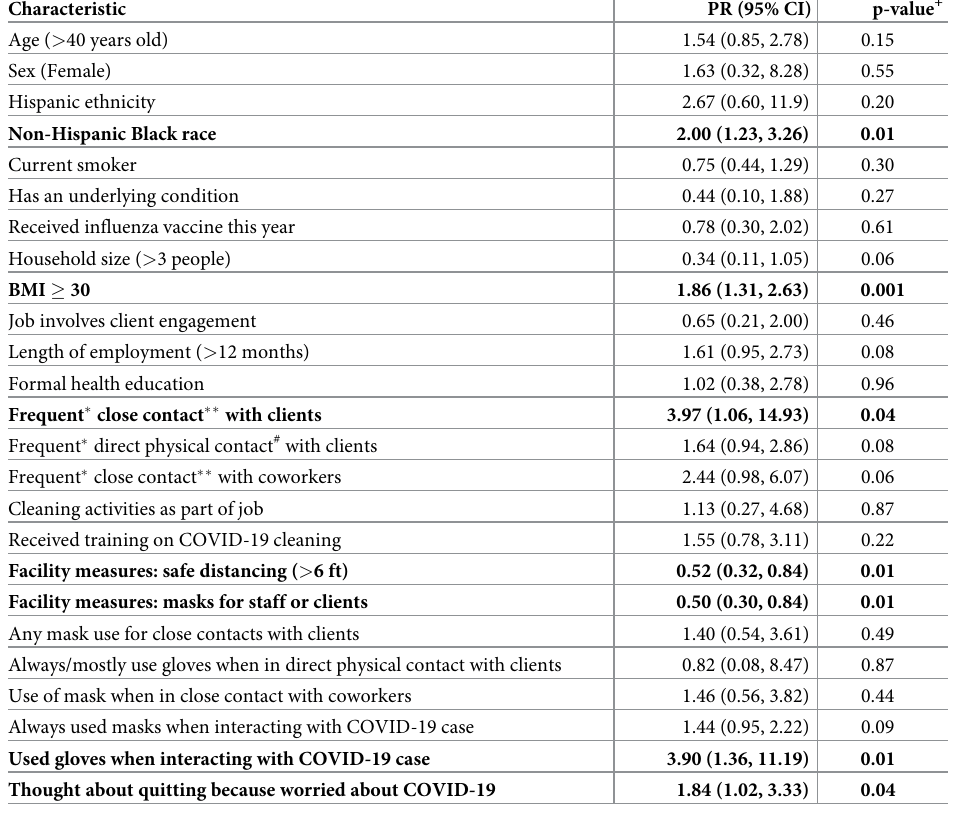
Table 4. Unadjusted prevalence ratios (PR) and 95% confidence intervals (CI) for factors associated with COVID- 19 positivity^ among homeless shelter workers (N = 77 participants who reported being tested).